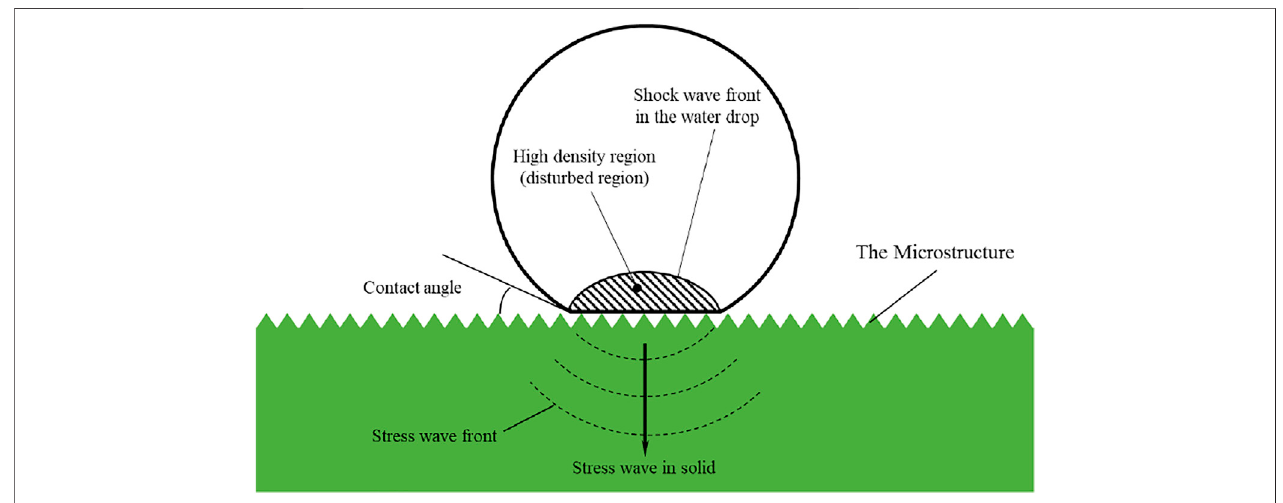
FIGURE 2 | The schematic of the liquid-solid impact